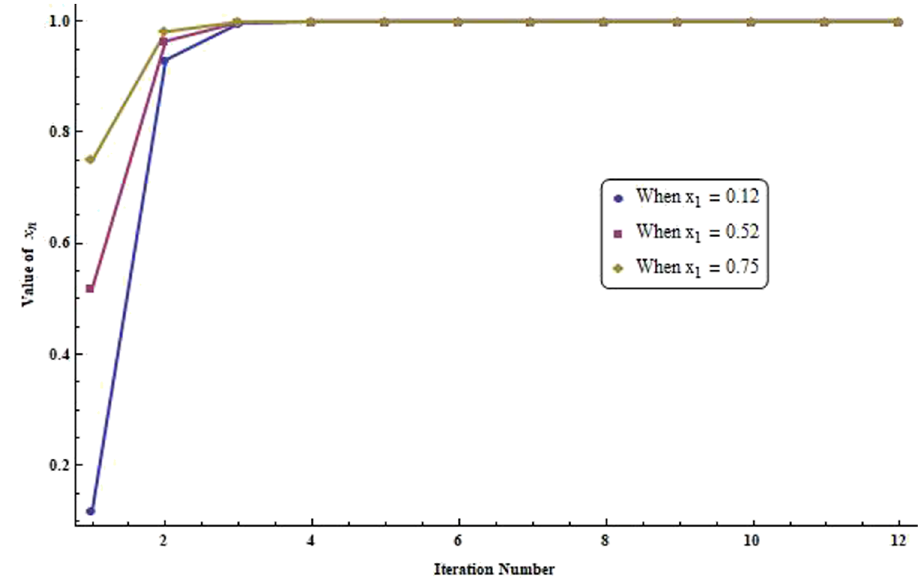
Figure 2: Graph corresponding to Table